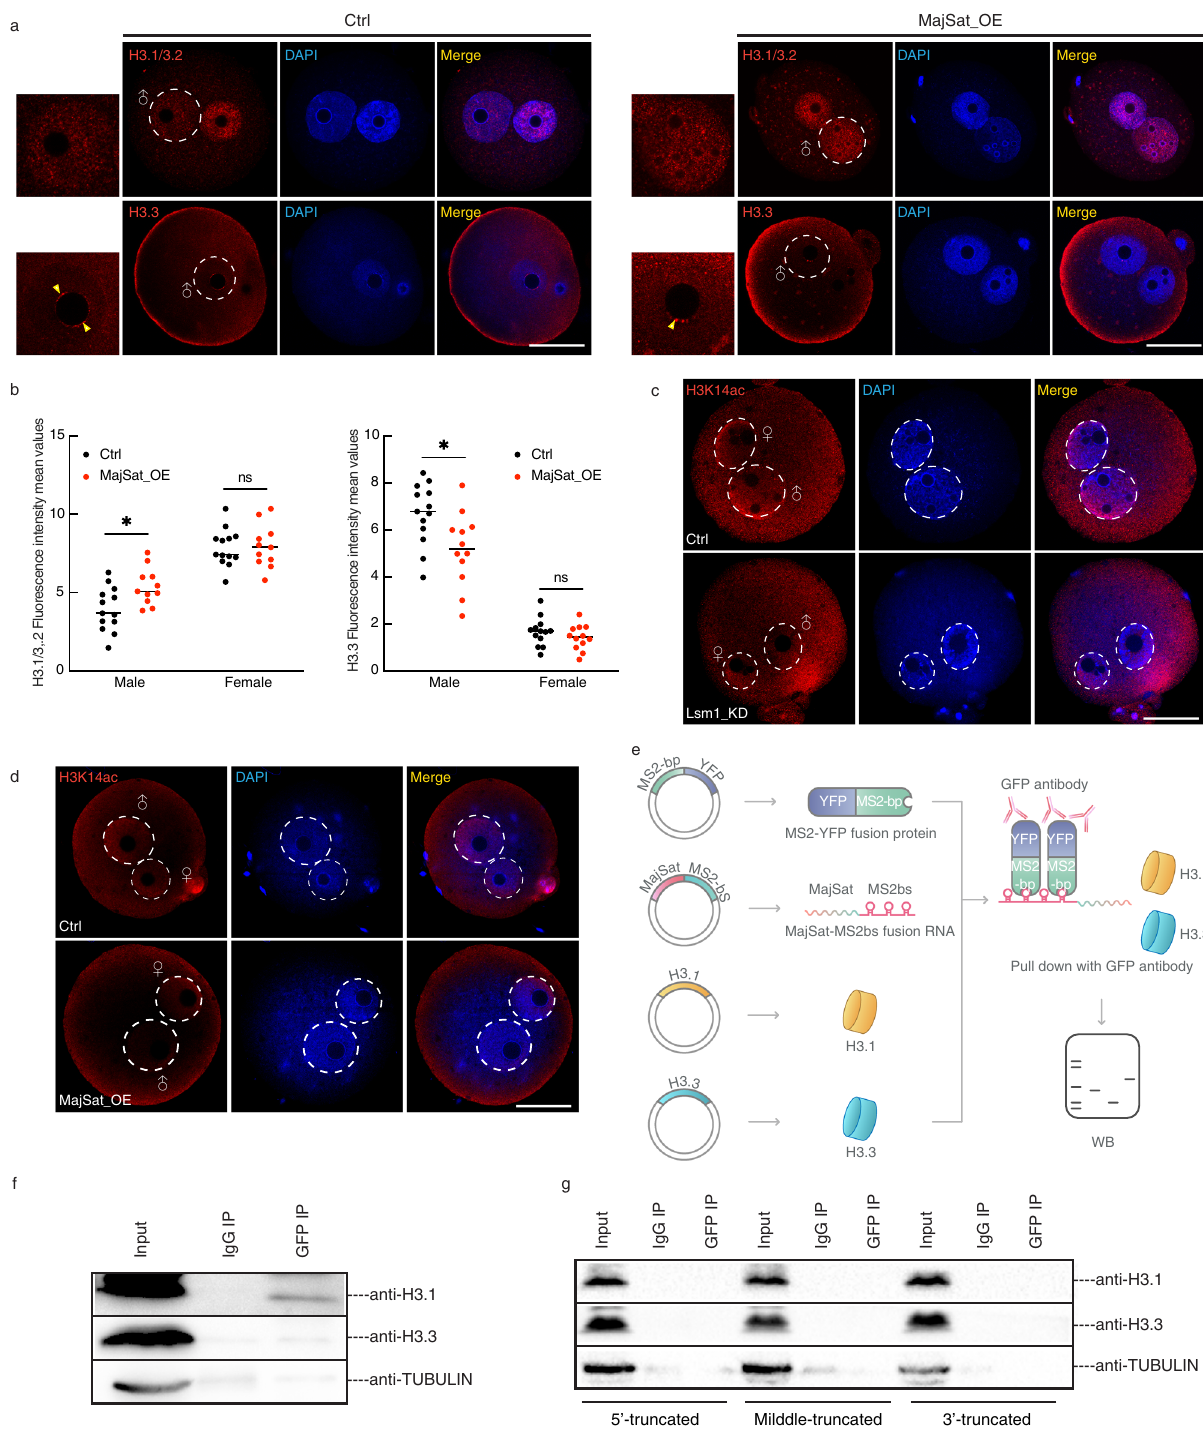
Fig. 5 | Abnormal H3K9me3 is incidental to incorrect H3.1/3.2 incorporation introduced by major satellite RNA. a Immunostaining for H3.1/3.2 and H3.3 in representative pronucleus of Ctrl and MajSat_OE zygotes. Scale bars, 20 µ m. Representative images from 3 biological replicates, with each replicate containing at least 10 zygotes. b Scatterplot showing H3.1/3.2 and H3.3 fl uorescence intensity mean values in pronucleus of Ctrl and MajSat_OE zygotes. The statistical data are expressed as mean±SEM, * p <0.05 and ns means not signi fi cant (H3.1/3.2: male p =0.0438, female p =0.6590, H3.3: male p =0.0380, female p =0.5885) by two- sided Student ’ s t test for each comparison. Each treatment contains 3 biological